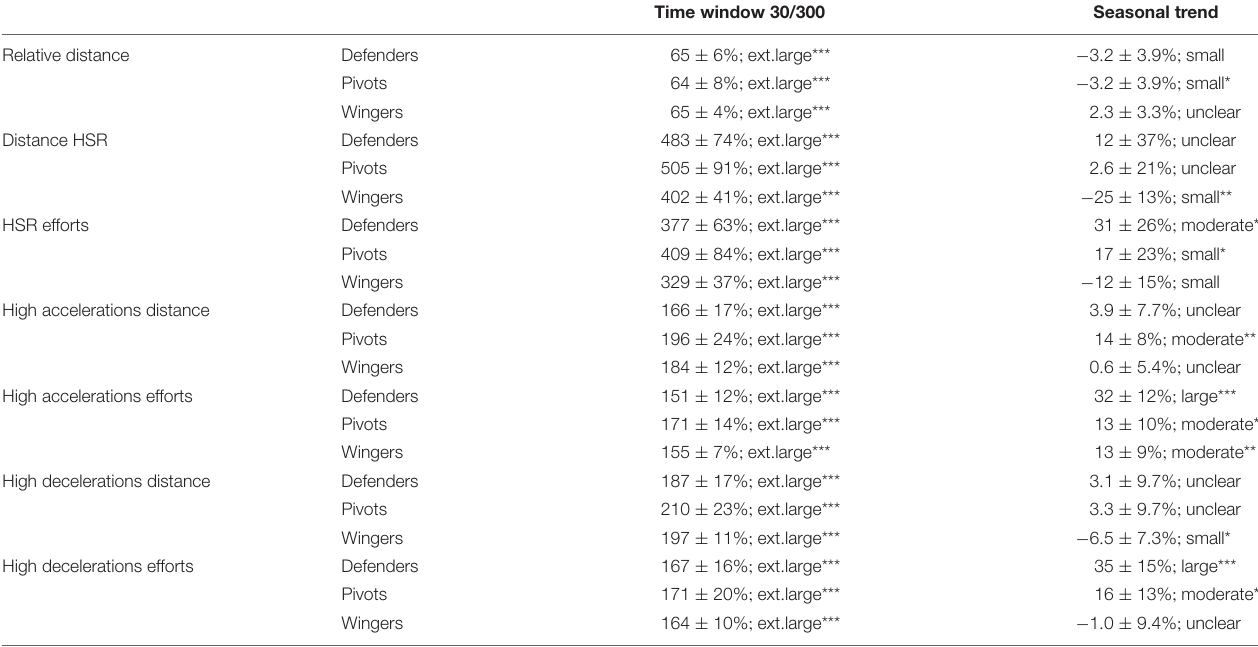
TABLE 2 | Fixed effects representing the effect of time window and the seasonal trend on all dependent variables for the three positional